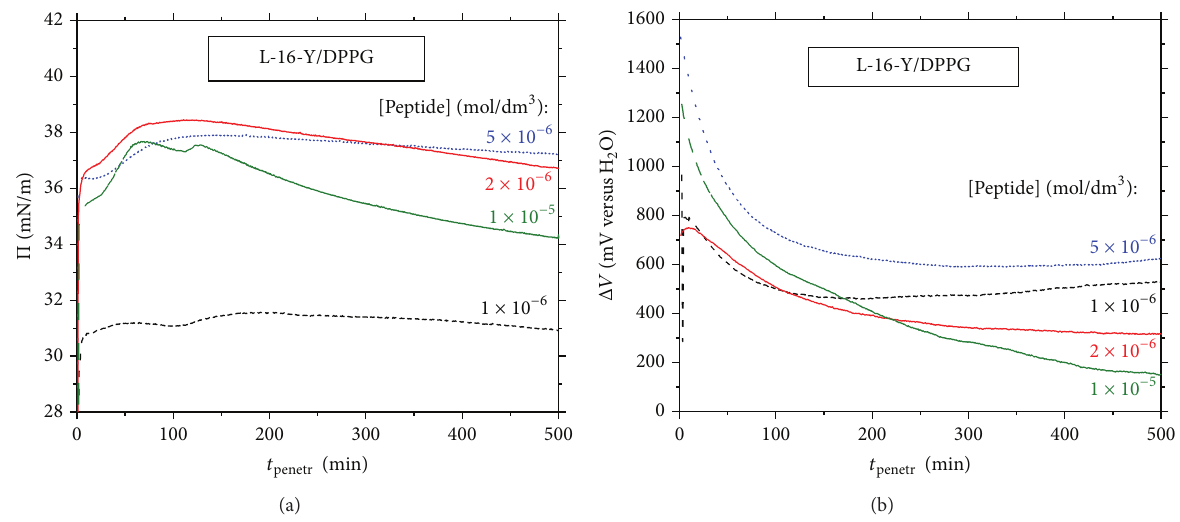
Figure 9: Long-time courses of (a) surface pressure, Π versus 𝑡 , and (b) electric surface potential, Δ𝑉 versus 𝑡 , owing to penetration of L-16-Y peptide to DPPG monolayers at various peptide concentrations (denoted therein). The initial surface pressure( Π was 30 ± 0.3 mNm −1 (typical of density of